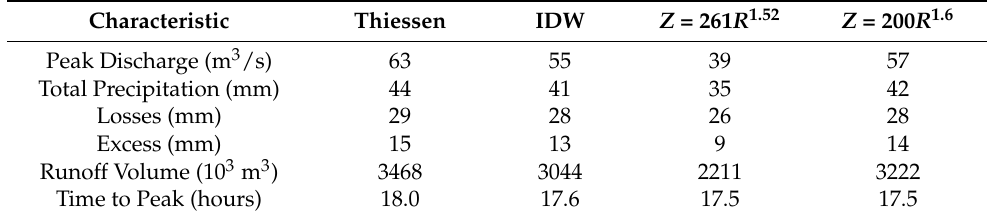
Table 2. Main characteristics of the generated hydrographs.